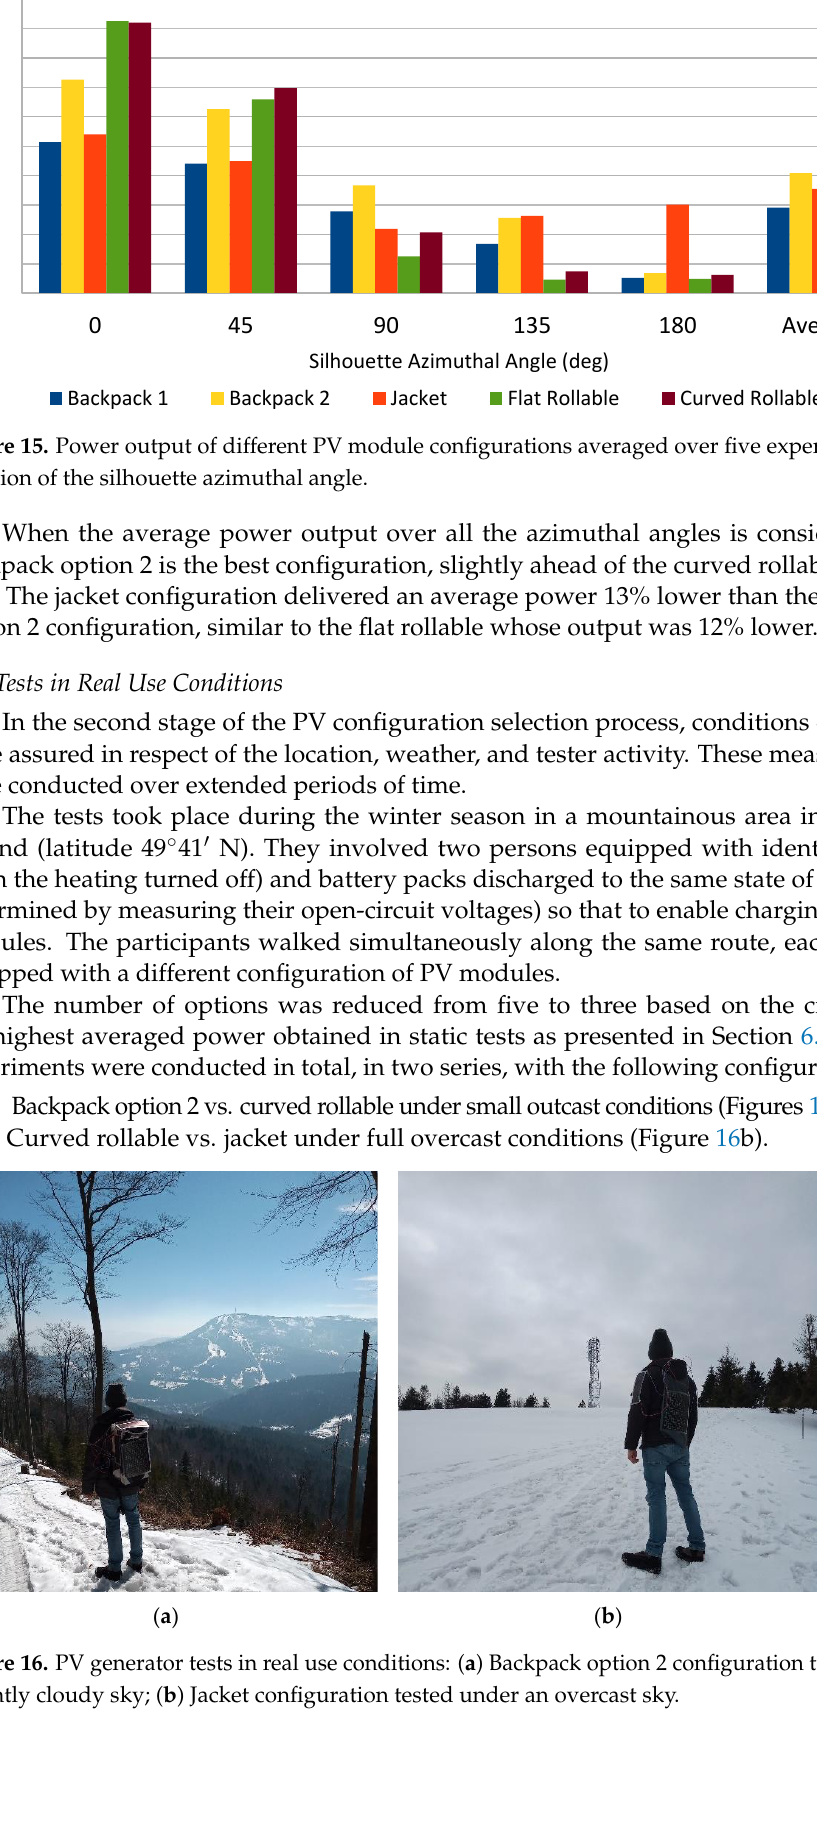
Figure 15. Power output of different PV module configurations averaged over five experiments as a function of the silhouette azimuthal angle.